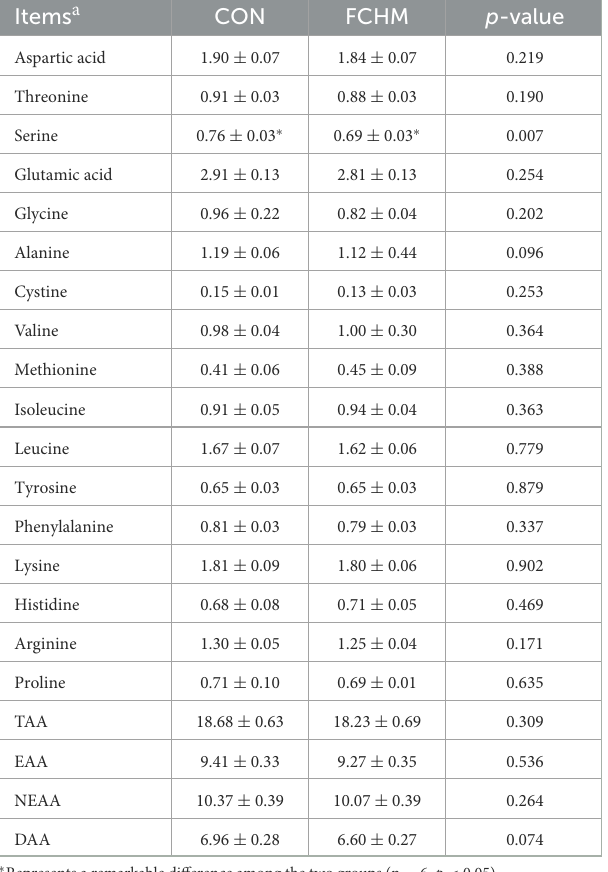
Figure 2. Supplementation with FCHM enhanced the expression of relative mRNA in broiler jejunum for tight junction proteins (ZO-1, Occludin, and Claudin; p < 0.05). Supplementation of FCHM significantly decreased the relative mRNA expression of immune genes (1L-1 β , 1L-6, TNF- α , and INF- γ ) in broiler jejunum ( p <